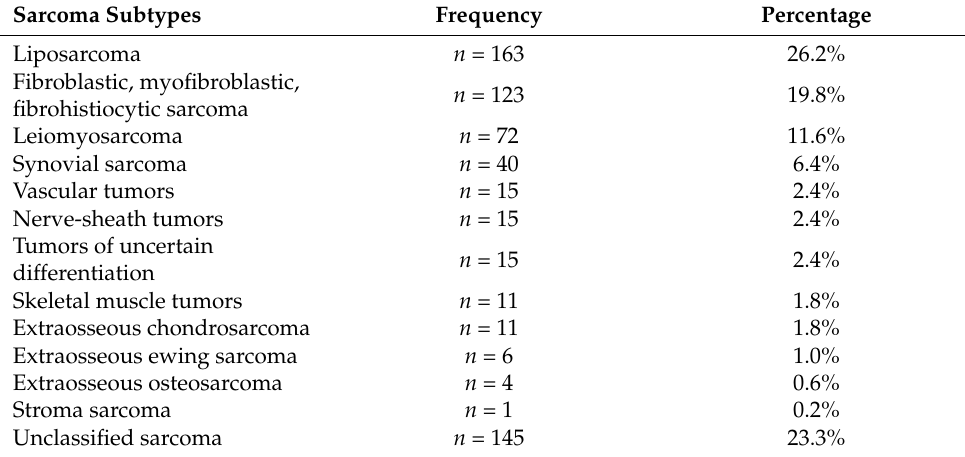
Table 1. Sarcoma